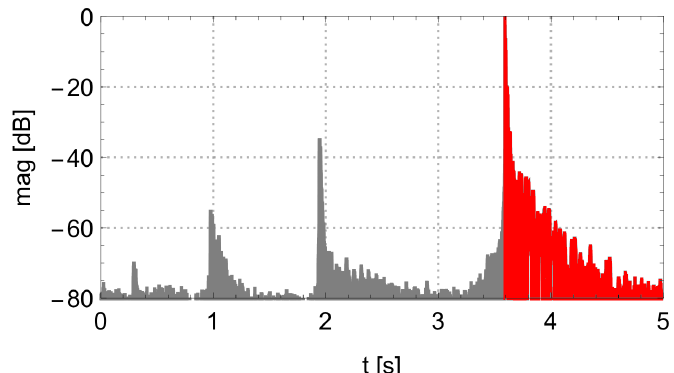
Figure 7. Obtained impulse response q (cid:48) ( X m , t ) of the signal in Figure 6 after deconvolution. The harmonic distortions are separated in time and precede the linear part q ( X m , t ) (red), which starts at t ≈